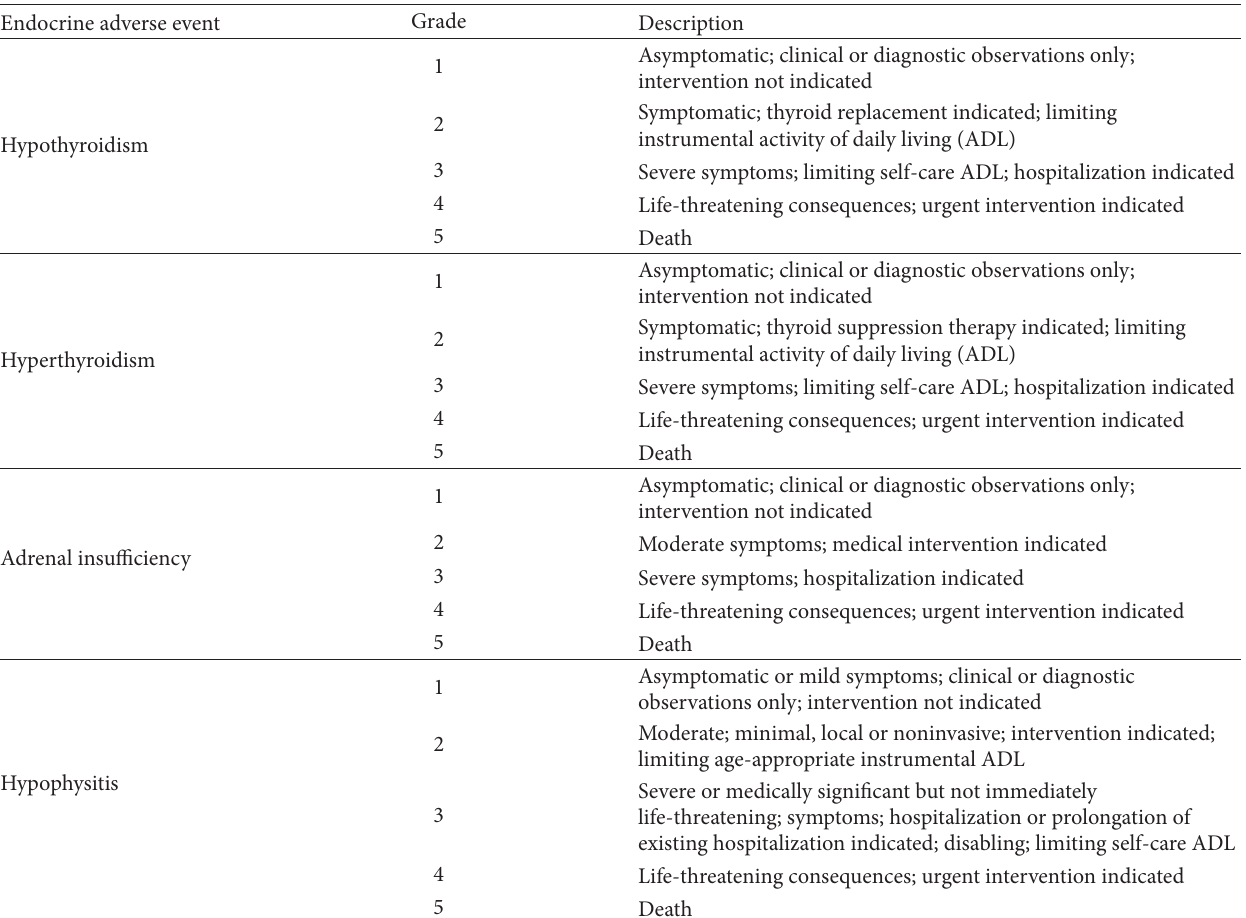
Table 2: Toxicity grading and endocrine adverse events associated with immune checkpoint inhibitors, according to Common Terminology Criteria for Adverse Events (CTCAE) of National Institutes of Health (National Cancer Institute) [2].